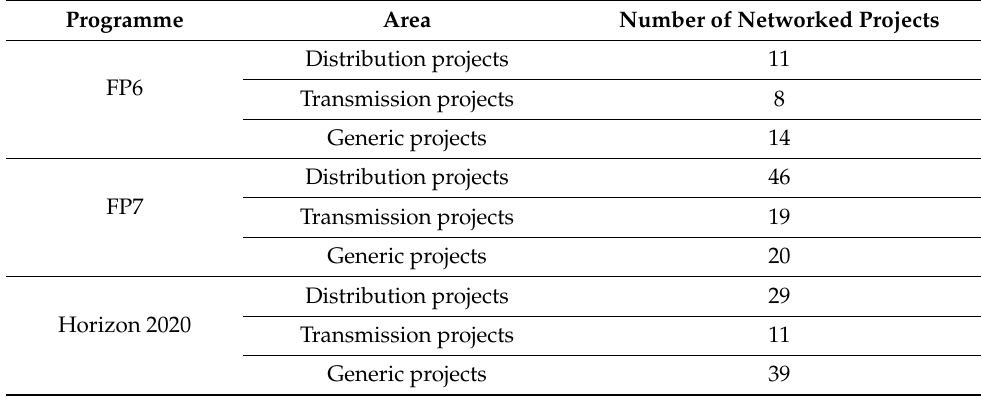
Table 7. The number of networked projects (N = 197) in the three different areas. Programme